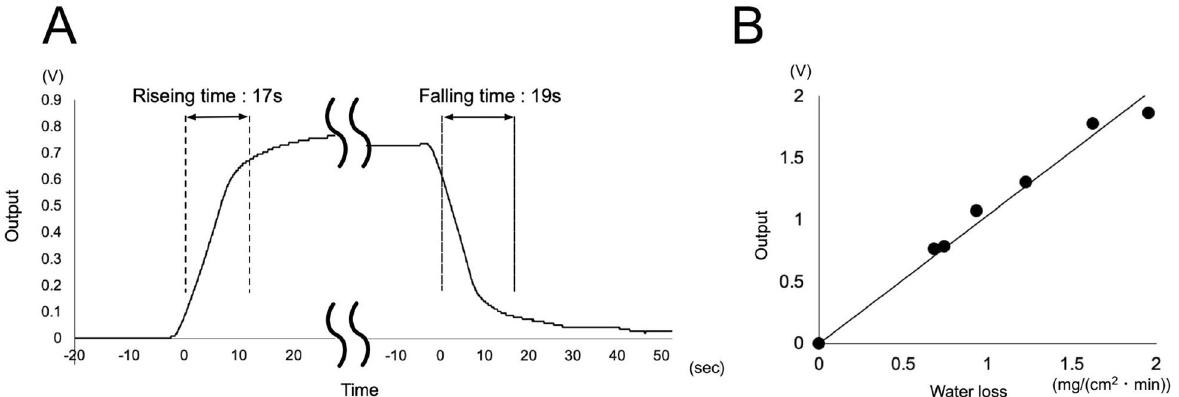
Figure 2. ( A ) Step response curve of wearable sweating ratemeter. Maximum response is obtained at approximately 17 s, and the baseline level regains the initial level after stopping the perfusion of air at 19 s. ( B ) Relationship between electrical output obtained with wearable ratemeter (the ordinate) and amount of water loss over 5 min (abscissa). The sensitivity of the wearable ratemeter is 1.0 V/1 mg/1